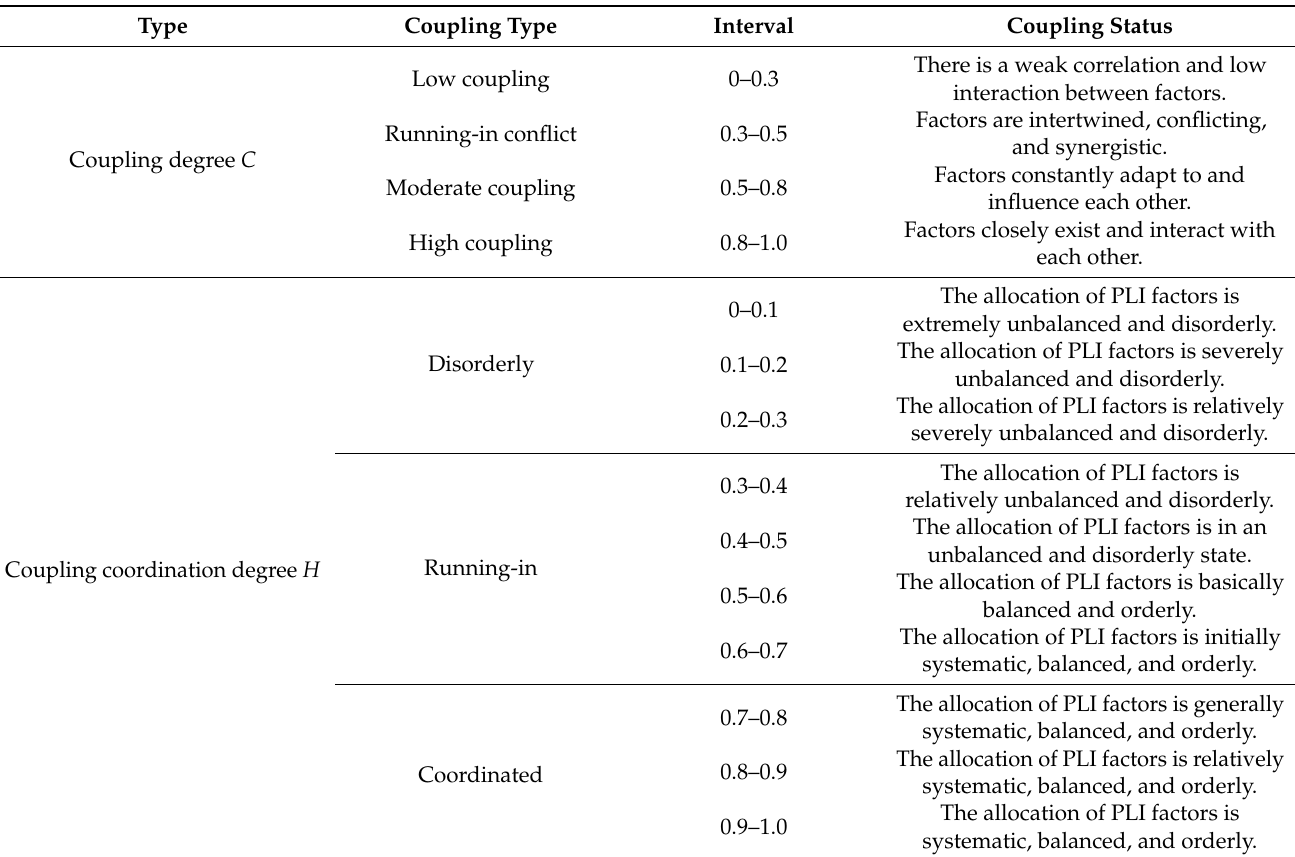
Table 1. Classification of PLI coupling